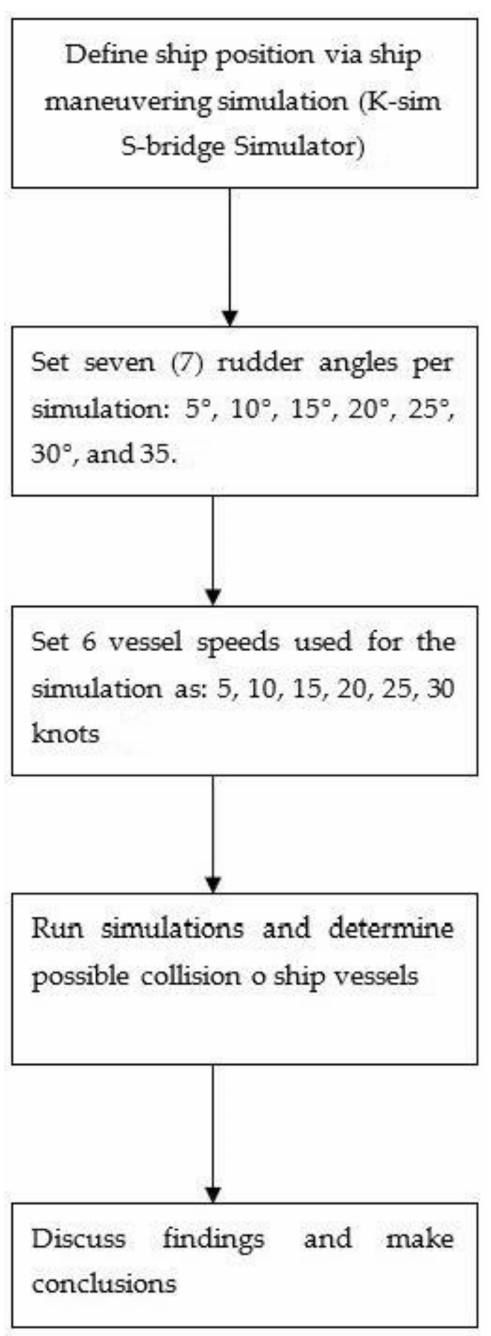
Figure 5. Flowchart summarizing the study